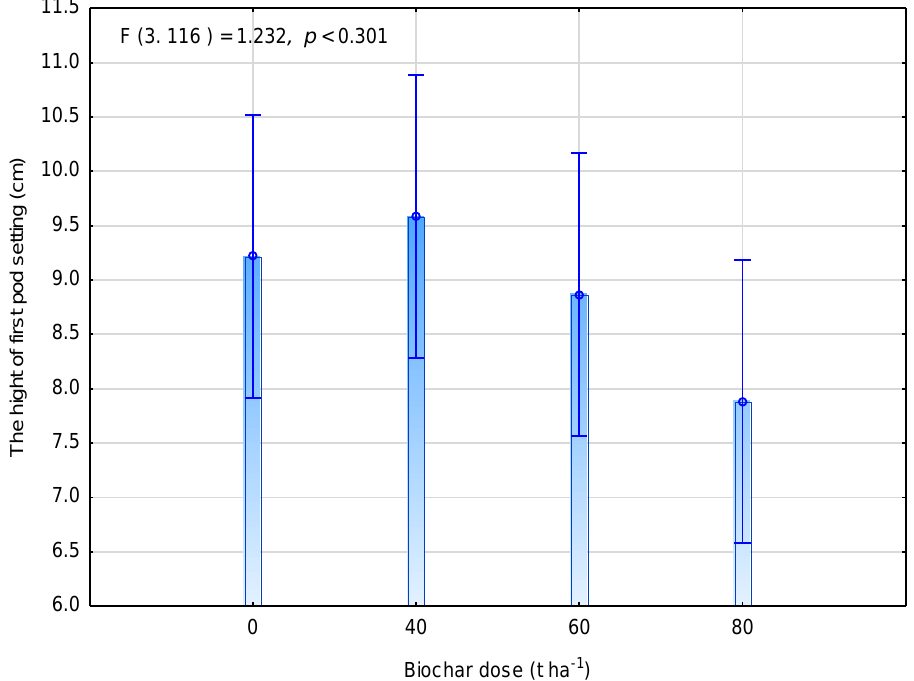
Figure 7. Height of the first pod setting depending on the level of biochar